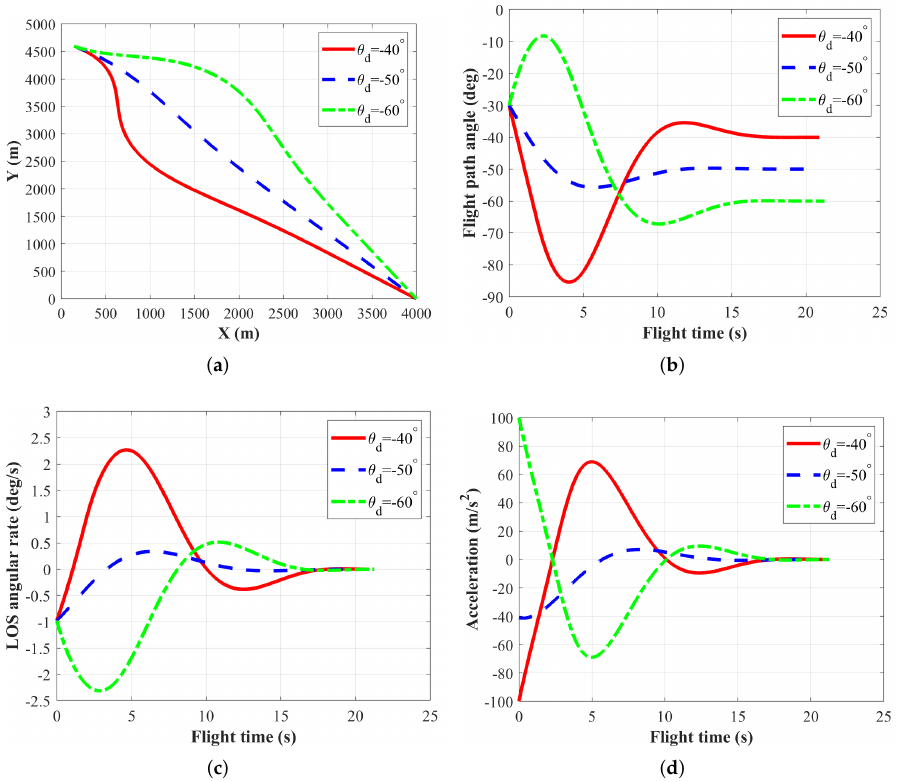
Figure 2. Simulation results under different expected terminal impact angles: ( a ) trajectory profiles; ( b ) flight path angle; ( c ) LOS angular rate; ( d ) acceleration